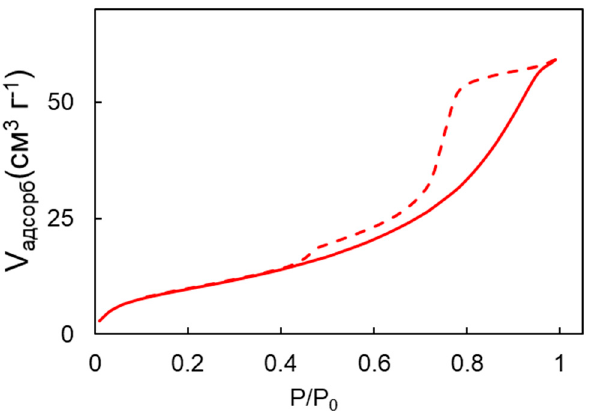
Figure 3. Isotherms of nitrogen adsorption and desorption of the synthesized nanoparticles.